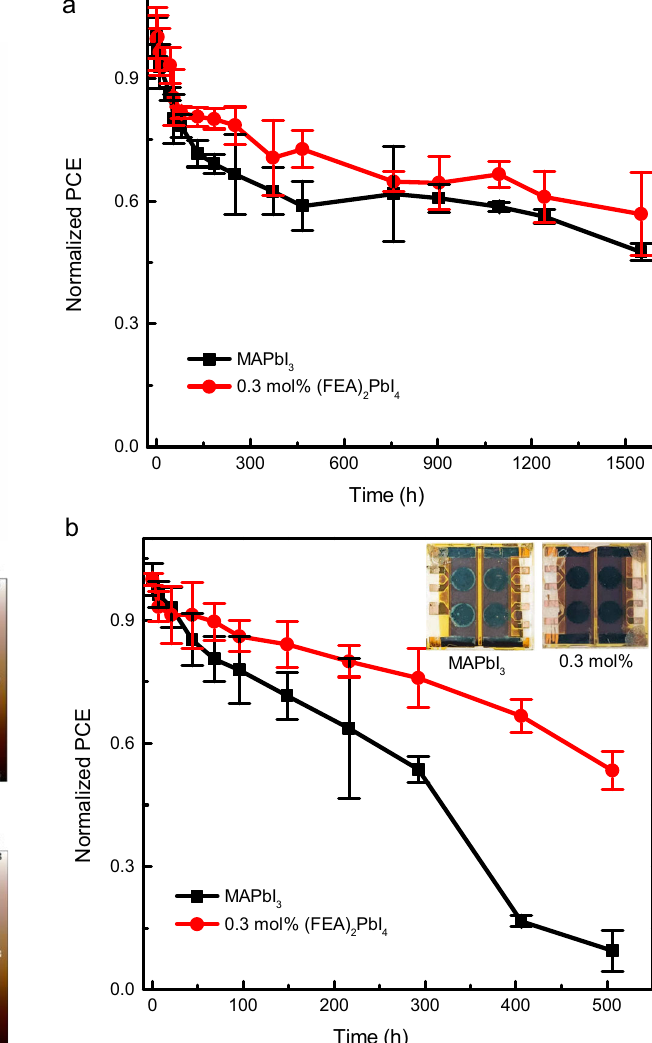
Fig. 6 Stability test of the MAPbI 3 and 0.3 mol% (FEA) 2 PbI 4 -containing devices without encapsulation. a Thermal stability test at 85 °C in a nitrogen atmosphere. b Humidity test in air with a relative humidity of 80 ± 10% at RT (PCE = power conversion ef fi measurements. Figure 5b shows that the average work function of the 0.3 mol% (FEA) 2 PbI 4 -containing fi lm was greater than that of neat MAPbI 3 and increasing the concentration caused a further increase in the average work function (Supplementary Fig. 13). By comparing the AFM and SKPM images, we found that the surface potential difference of the fi lms was highest at the grain boundaries, which is consistent with a higher concentration of the (FEA) 2 PbI 4 being present in between the grains. Solar cell stability . Long-term stability measurements of the optimized MAPbI 3 and 0.3 mol% (FEA) 2 PbI 4 -containing solar cells were carried out under two different conditions. The unencapsulated cells were either stored in the dark at 85 °C in a nitrogen- fi lled glovebox or in the dark in air at a relative humidity of 80 ± 10% and measured at periodic intervals (Fig. 6). Under our measurement conditions, both thermally treated devices showed an initial relatively rapid decrease in performance with T80s of around 55 and 183 h for the MAPbI 3 and 0.3 mol% of (FEA) 2 PbI 4 devices, respectively (Fig. 6a). However, over a longer